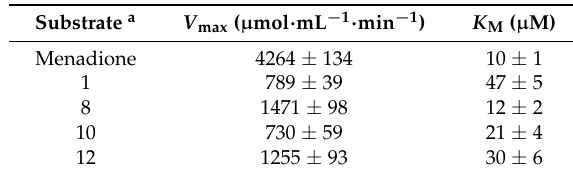
Table 1. Kinetic constants of hQR2 for the substrates tested. Results are the mean ± SD of three separate determinations.